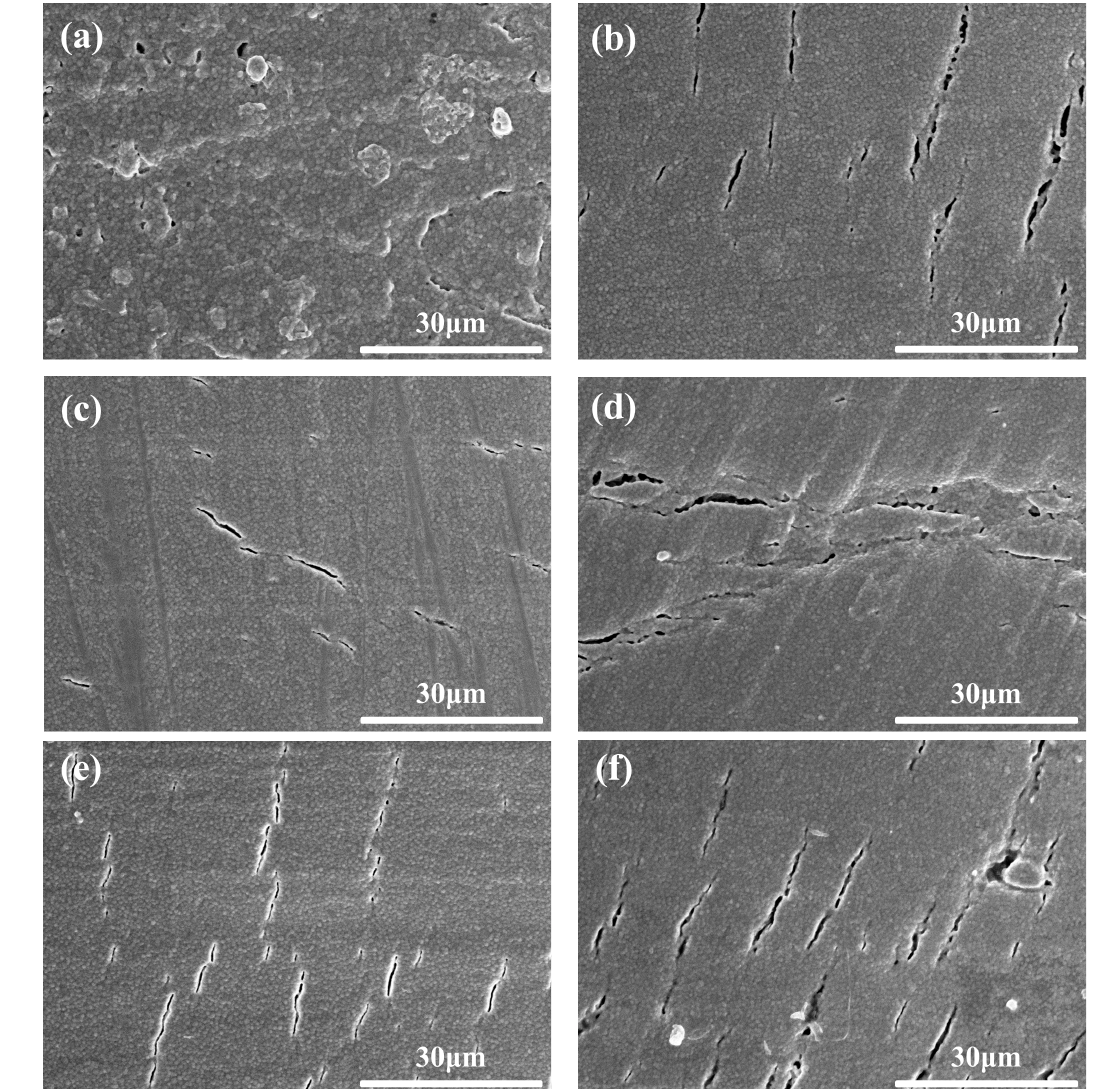
Figure 10. Surface morphologies of the sintered samples with different coupling media at 1575 °C for 2 h. ( a ) sample A, ( b ) sample B, ( c ) sample C, ( d ) sample D, ( e ) sample E, and ( f ) sample F.